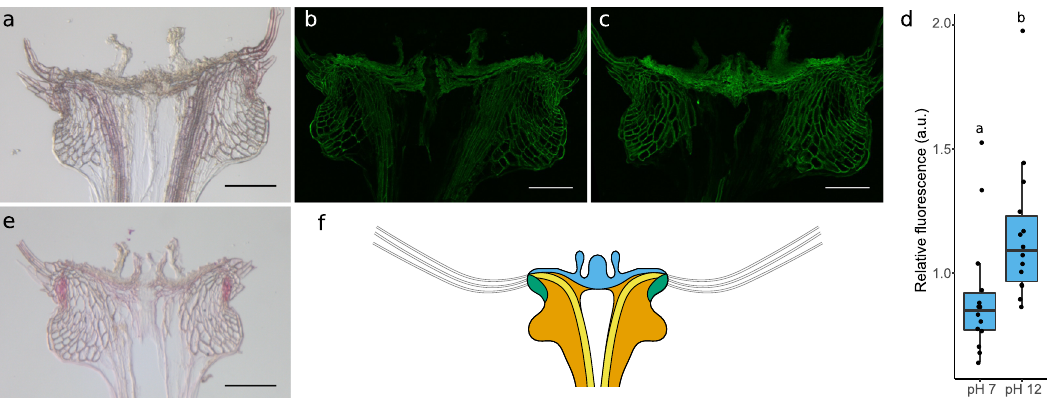
Fig. 3 Apical plate composition. a Phloroglucinol-HCl staining for lignin, image is representative of n = 9 samples, scale bar is 100 μ m. b , c UV auto fl uorescence at b ph 7, and c pH 12. Images are representative of n = 14 samples, scale bars are 100 μ m. d Quanti fi cation of auto fl uorescence signal, n = 14 per treatment. Different letters above boxplots indicate signi fi cant differences with a two-sided Wilcoxon signed rank test, p = 0.0001. The centre line is the median, hinges indicate fi rst and third quartiles, and whiskers extend to largest value no further than 1.5 times the interquartile range. e Sudan Red 7b staining for lipids, images are representative of n = 10 samples, scale bar is 100 μ m. f Illustration of the different regions of the apical plate with fl oral podium in blue, cortex in orange, vasculature in yellow and side regions in